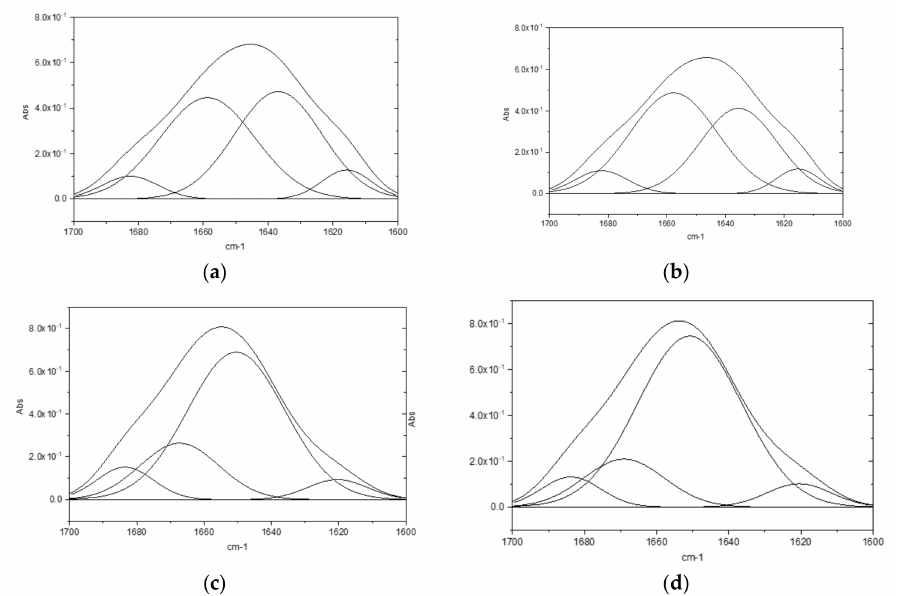
Figure 3. ATR-FTIR deconvolution: ( a ) lysozyme HCl powder; ( b ) heat-treated lysozyme HCl powder; ( c ) lysozyme HCl aqueous solution (2 mg/mL); ( d ) heat-treated lysozyme HCl aqueous solutions (2